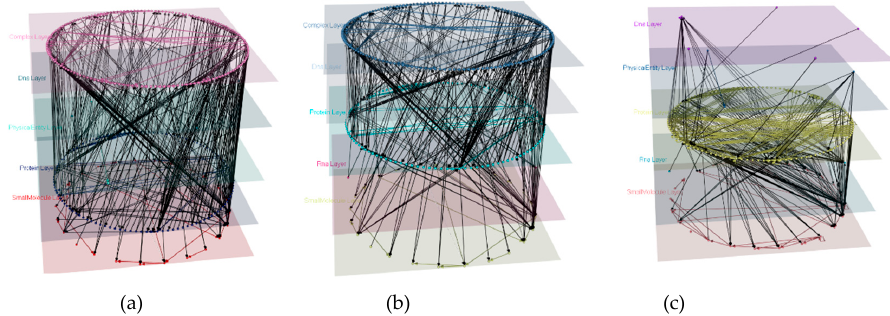
Figure 6. Views generated from the Signaling by Wnt mully model. ( a ) View1 generated by deleting the RNA layer. The graph has 5 layers, 309 nodes, and 533 edges. ( b ) View2 generated by deleting the PhysicalEntity layer. The graph has 5 layers, 308 nodes, and 522 edges (521 edges from the original graph and 1 transitive). ( c ) View3 generated by deleting the Complex layer. The graph has 5 layers, 153 nodes and 800 edges (93 edges from the original graph and 707 transitive).